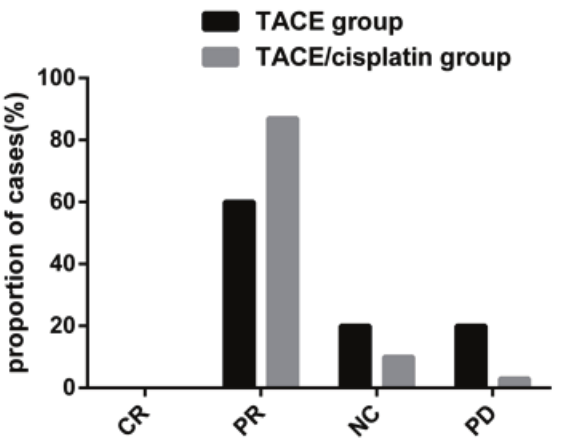
Figure 1: Proportion of cases with different therapeutic outcomes in TACE group and TACE/cisplatin group